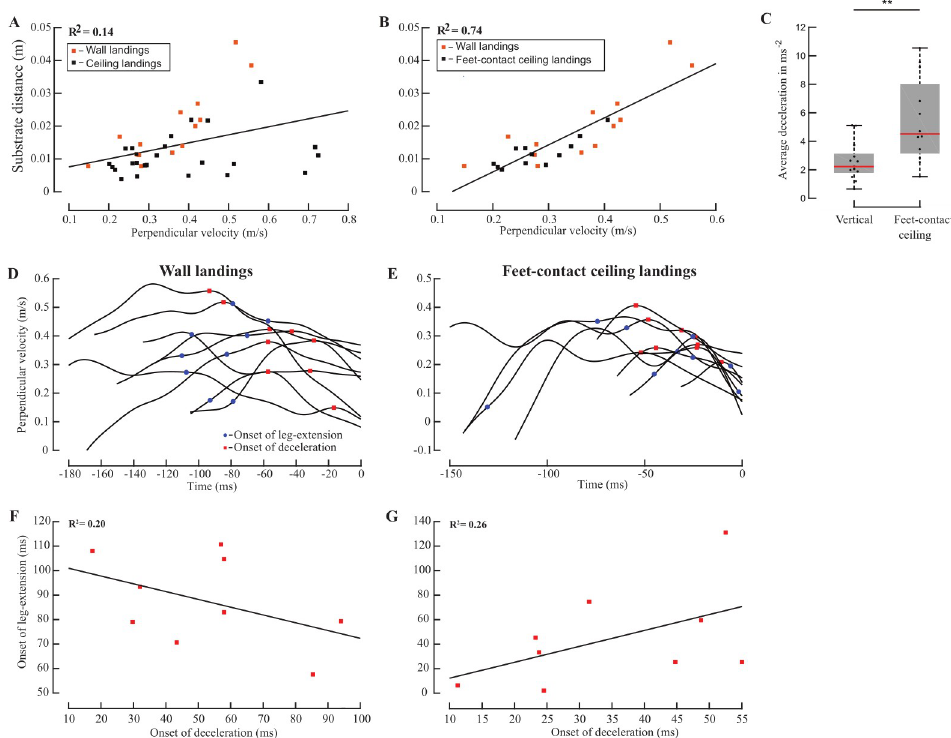
Fig 5. Comparing the onset of deceleration of wall and ceiling landings, and testing for correlation between the onsets of deceleration and leg-extension. (A) Substrate distance versus perpendicular velocity at the onset of deceleration for vertical (orange squares, n = 13) and ceiling landings (black squares, n = 25, R 2 = 0.14). (B) Substrate distance versus perpendicular velocity at the onset of deceleration for vertical (n = 13) and feet-contact inverted (n = 12) landings (R 2 = 0.74). (C) Flies performing feet-contact landings on inverted substrates decelerated at significantly higher rates compared to flies landing on vertical substrates (Wilcoxon ranksum test, p < 0.01). (D, E) Perpendicular velocity vs. time for all trials (n = 9) in which onsets of deceleration (red squares) and leg-extension (blue circles) were known for (D) wall and (E) feet-contact ceiling landings. (F, G) Time-to-collision at onset of leg-extension versus time- to-collision at the onset of deceleration for (F) all 9 wall landings depicted in (D), and (G) all 9 feet-contact landings depicted in (E). Low R 2 imply weak correlation.